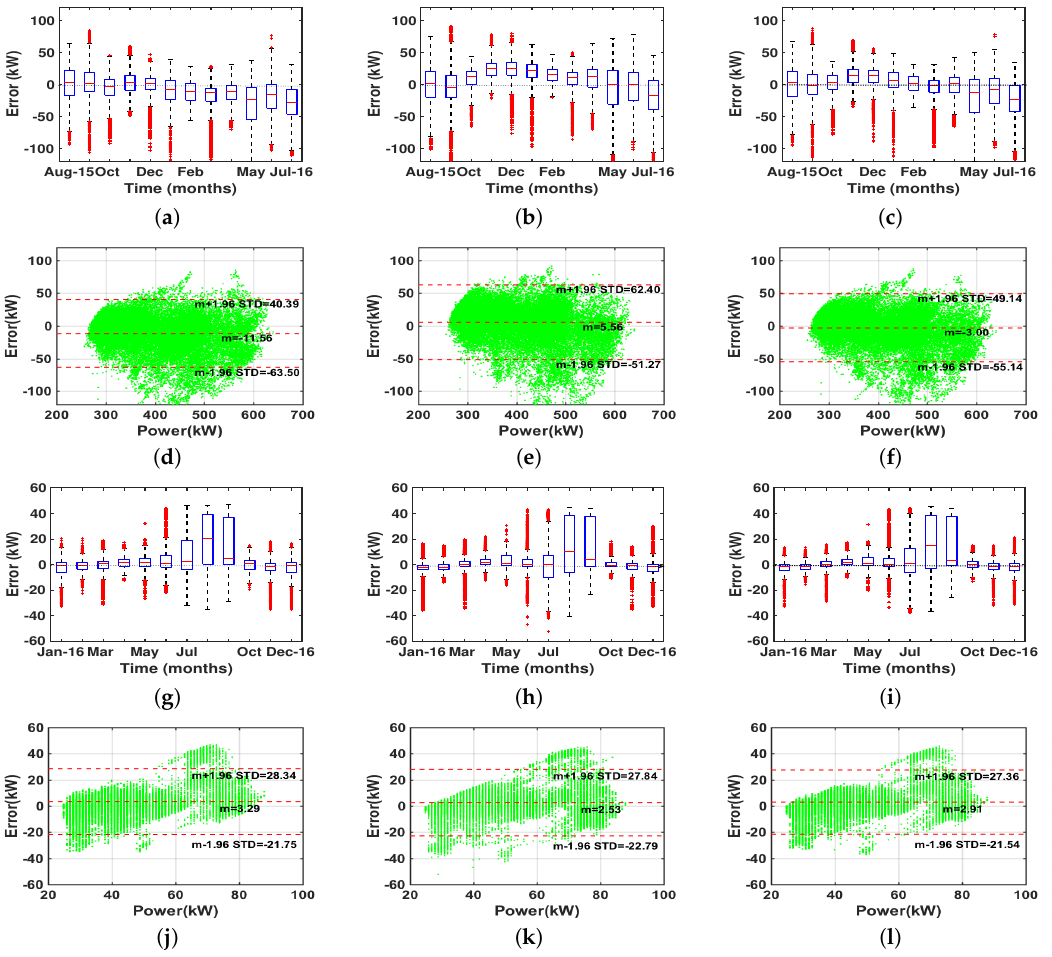
Figure 4. Residual analysis for mid-term load forecasting for Hospital Universitario de Fuenlabrada (HUF) from September 2015 to August 2016 ( a - f ) and for Centro de Especialidades El Arroyo (CEA) from January 2016 to December 2016 ( g – l ). Models for HUF, including residual plots for principal component analysis (PCA) ( a ), orthonormal partial least squares (OPLS) ( b ), and ensemble output ( c ), as well as Bland–Altman plots ( d , e , f ), in the same order; ( g – l ) show the same representations with CEA